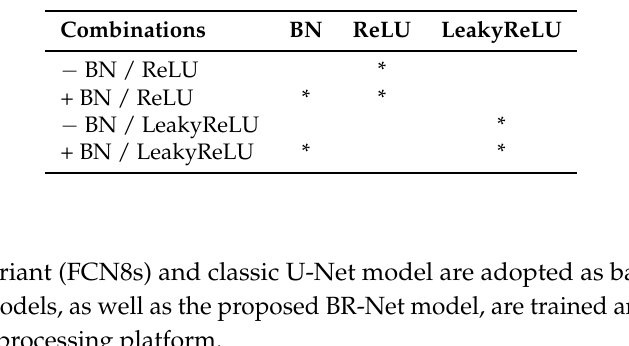
Table 1. Component combinations of BR-Net models.